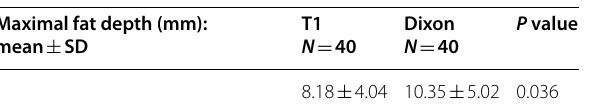
Table 2 Comparison between MRI T1 and Dixon in maximum fat depth